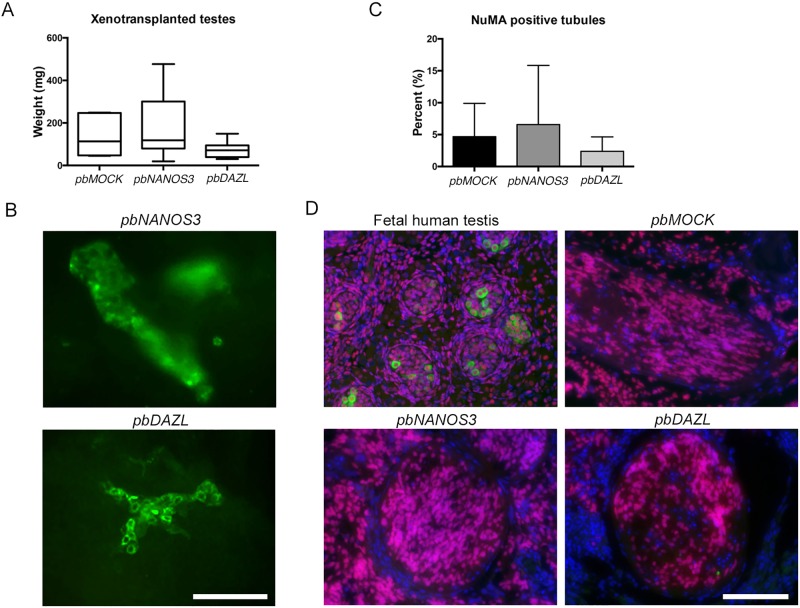
Xenotransplantation of transfected cells into the seminiferous tubules of mouse testes.A) Weight of the xenografts collected 8 weeks after transplantation, n ≥ 3. B) Whole mount staining with an antibody against primate testis cells. A cell clump was observed in one pbNANOS3 transplanted testis. Six colonies with spermatogonial characteristics were observed in one pbDAZL transplanted testis, representative image shown. Scale bar: 100 μm. See also S4 Table. C) Serial sections from xenografts with weight < 150mg were screened for intratubular NuMA positive cells and percentage of positive tubules was calculated. Data are represented as mean ± SD, n ≥ 3. See also S4 Table. D) Immunofluorescence staining for human specific NuMA (red) and DDX4 (green). Human fetal testis sample was used as positive control. Representative images with intratubular NuMA positive and DDX4 negative cells are shown for pbMOCK, pbNANOS3 and pbDAZL xenografts. Cells were counterstained with DAPI (blue). Scale bar: 100 μm.